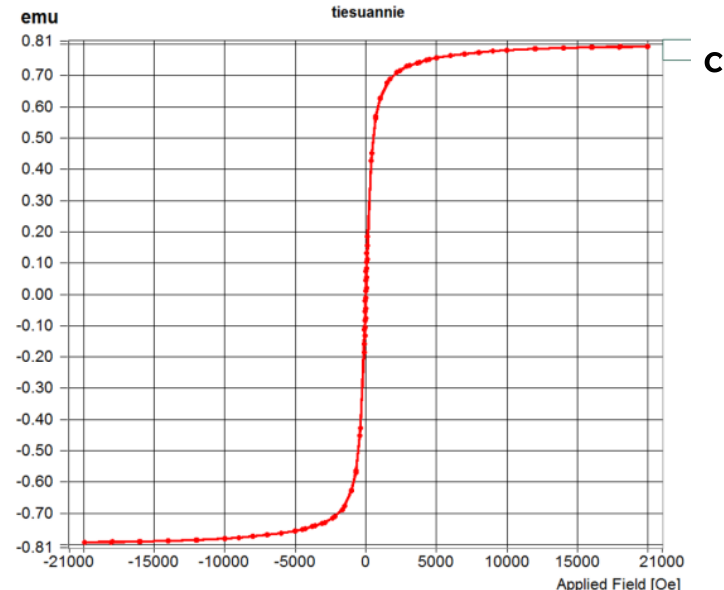
Figure 2. SEM image ( a ), XRD pattern ( b ), and VSM ( c ) of NiFe 2 O 4 . The structure of the NiFe 2 O 4 was determined by X-ray diffraction (XRD). As shown in Figure 2b, the diffraction peaks of NiFe 2 O 4 appeared at 2 θ = 18.4 ◦ , 30.3 ◦ , 35.7 ◦ , 43.4 ◦ , 53.8